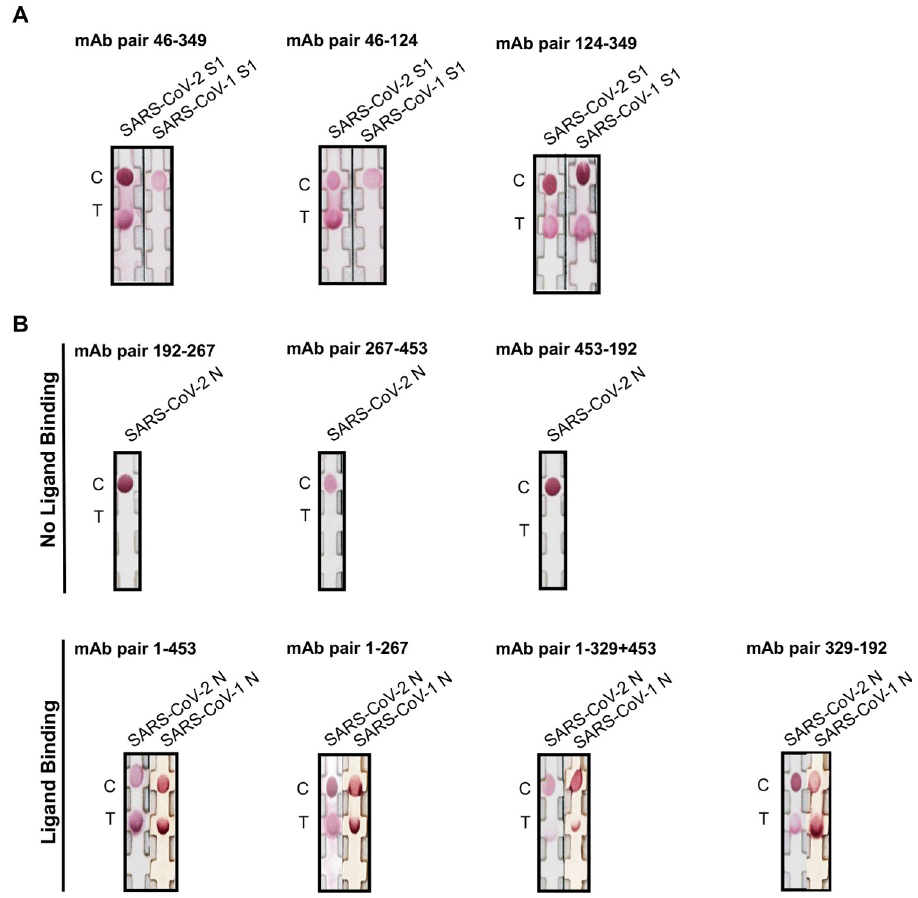
Fig 4. SARS-CoV-2 S1 and N interactions in lateral flow immunochromatography. mAbs were either conjugated to gold nanoparticles or adsorbed onto the nitrocellulose membrane. Different combinations were tested to distinguish between specific and cross-reactive detection and indicate differential epitope binding. SARS-CoV-1/2 S1 or SARS-CoV-1/2 N, at final concentrations of 125 ng/ml, were allowed to react with the rapid antigen test. (A) mAb pairs 46–349 and 46–124 specifically recognize SARS-CoV-2 S1, whereas mAb pair 124–349 recognize both SARS-CoV-2 S1 and SARS-CoV-1 S1. (B) Ligand binding is not observed in rapid tests composed of mAb pairs 192– 267, 267–453, and 453–192. However, ligand binding occurs with mAb combinations 1–453, 1–267, 1–329+453, and 329–192; these combinations detect both SARS-CoV-1 and SARS-CoV-2 N. C, control. T,